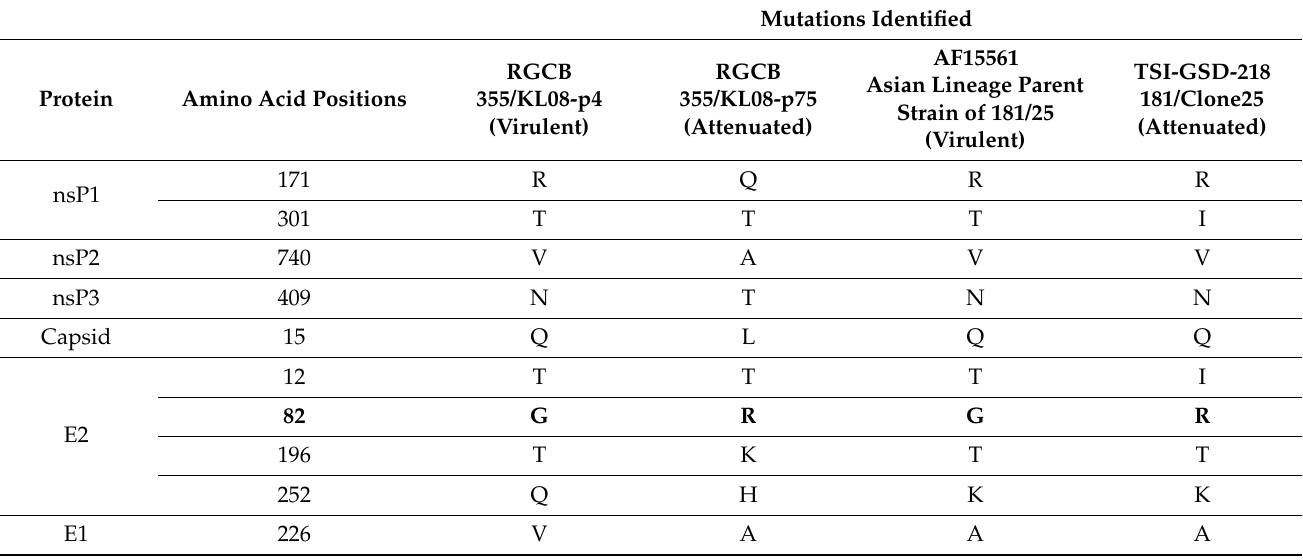
Table 2. Key amino acid variations in attenuated CHIKV strains.